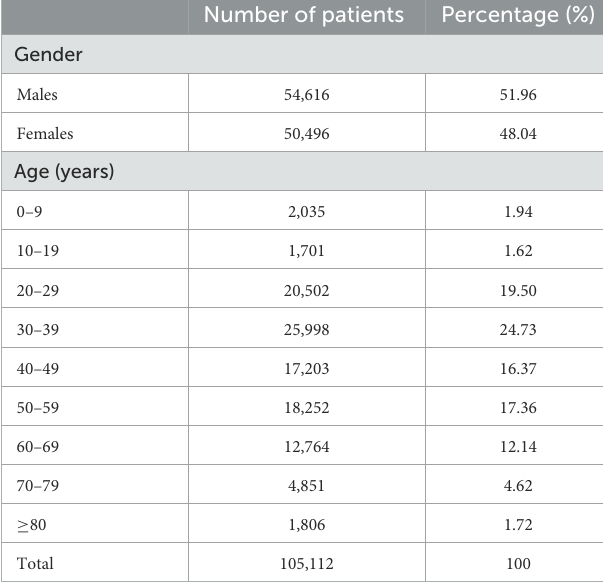
TABLE 1 Demographic characteristics of the included